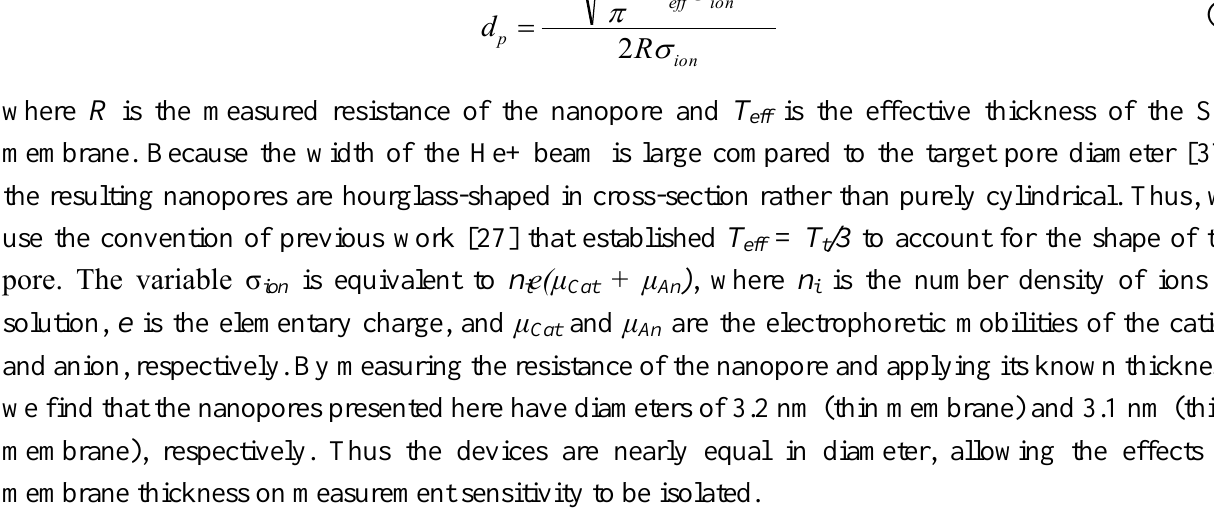
Figure 5. dsDNA translocation measurements. ( a ) Typical raw current traces measured with two SS-nanopore devices: one 3.2 nm in diameter in a 4.5 ± 0.6 nm thick membrane (blue) and one 3.1 nm in diameter in a 24.5 ± 0.8 nm thick membrane (red). Upon addition of dsDNA, a series of translocation events are recorded. Traces are subject to a low-pass filter of 10 kHz; ( b ) Scatter plot of event durations and mean current blockages for events recorded through the thin (blue, n = 191) and thick (red, n = 56) devices in (a). Accompanying current blockage histogram shows significantly (~2-fold) deeper events are observed for the thin SS-nanopore